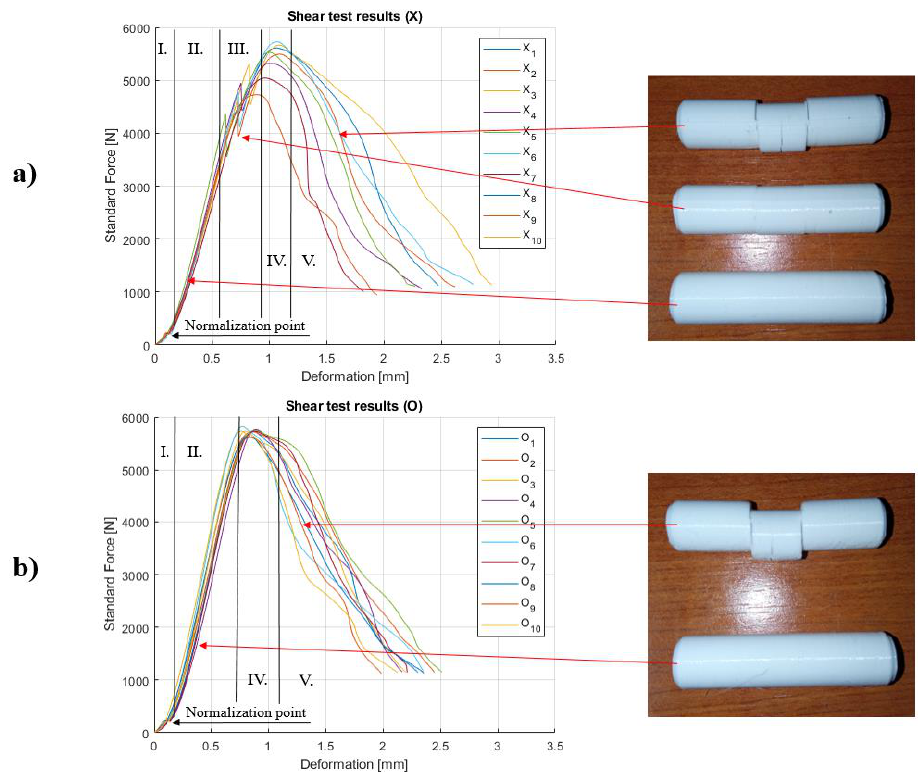
Figure 3. Shear test results with the main characteristic sections: ( a ) X samples and ( b ) O samples